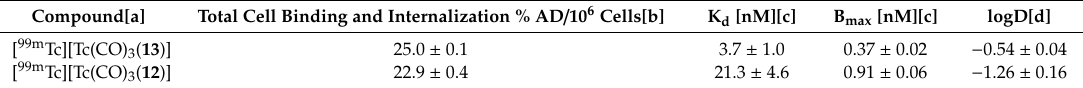
Table 2. Results from in vitro experiments with 99m